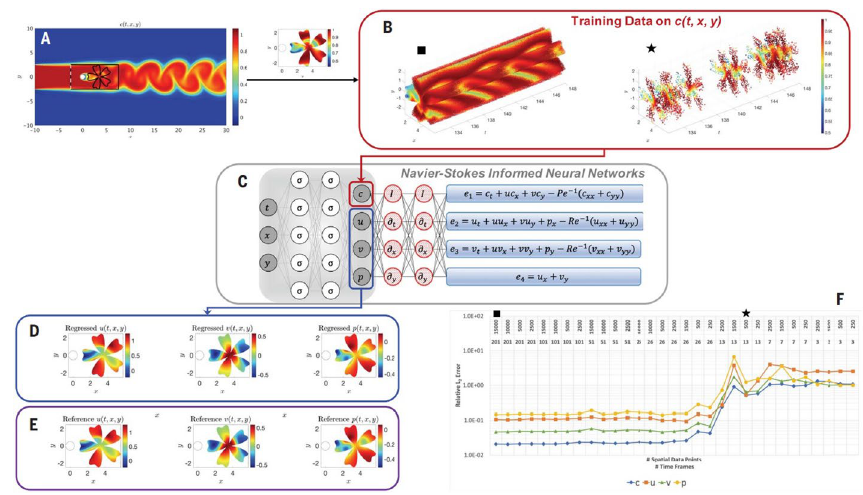
Fig. 24 Arbitrary training domain in the wake of a cylinder. A The domain where the training data for concentration and reference data for the velocity and pressure are generated by using direct numerical simulation. B Training data on concentration c(t, x, y) in an arbitrary domain in the shape of a flower located in the wake of the cylinder. The solid black square corresponds to a very refined point cloud of data, whereas the solid black star corresponds to a low‑resolution point cloud. C A physics‑uninformed neural network (left) takes the input variables t, x, and y and outputs c, u, v, and p. By applying automatic differentiation on the output variables, we encode the transport and NS equations in the physics‑informed neural networks ei, i 1,..., 4 (right). D Velocity and pressure fields regressed by means of HFM. E Reference velocity and = pressure fields obtained by cutting out the arbitrary domain in A , are used for testing the performance of HFM. F Relative L2 errors are estimated for various spatiotemporal resolutions of observations for c. On the top line, we list the spatial resolution for each case, and on the line below, we list the corresponding temporal resolution over 2.5 vortex shedding cycles (Adopted from